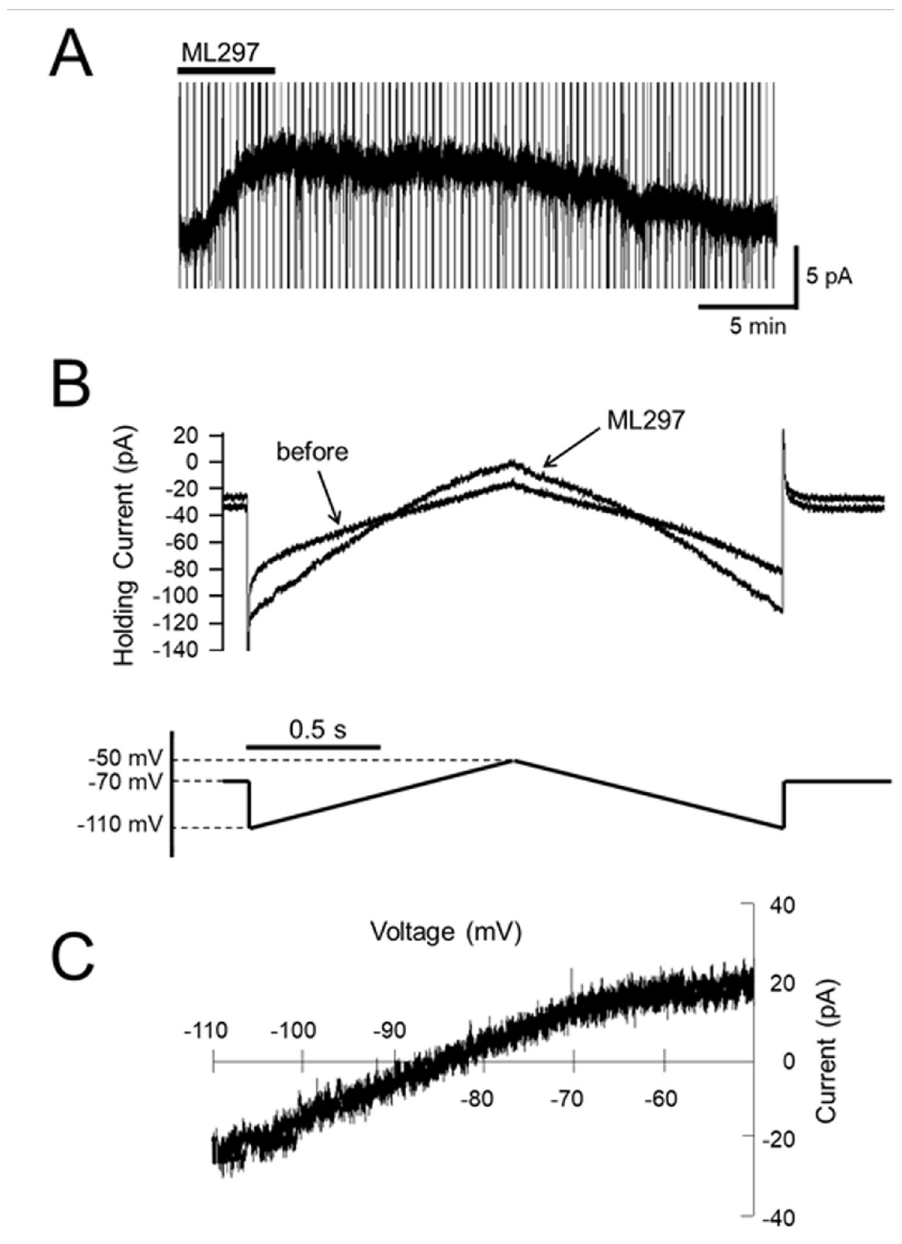
Fig 3. Voltage dependency of ML297-induced current. (A) Representative recording of ML297-induced outward current in voltage-clamp mode (V H = -70 mV) with voltage ramp commands in a spinal cord slice preparation. Vertical lines are traces of the current response to voltage ramp commands. (B) Current response to the voltage ramp (lower trace) over an expanded time base. The current-voltage relationship was recorded at the peak response to ML297 application. (C) Current-voltage relationship. The current-voltage relationship identified that the reversal potential of ML297 was close to that of the other families of potassium channels.